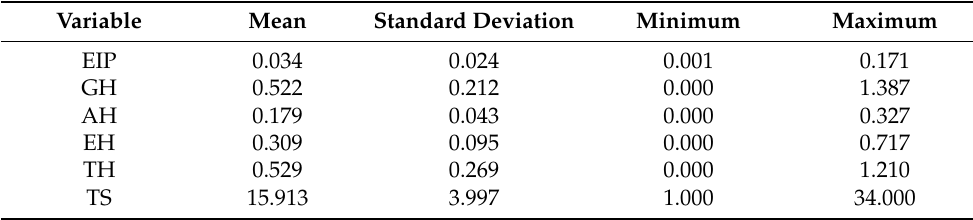
Table 2. Descriptive statistical